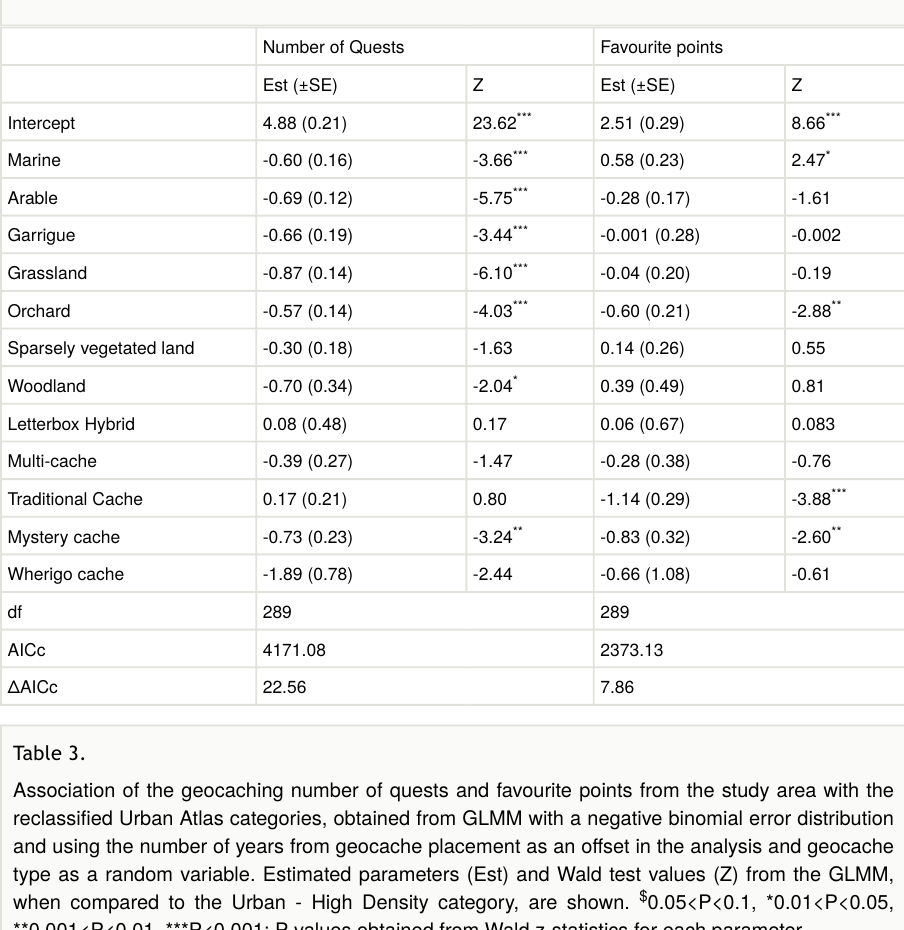
Parameter estimates using GLM with a negative binomial distribution for the number of quests and favourite points when compared to the Urban LULC are shown. The most parsimonious model (lowest Akaike Information Criterion with a second order correction, AICc) for each response variable was selected as the best model. *0.01<P<0.05, **0.001<P<0.01, ***P<0.001;(cid:10) P values obtained from Wald test statistic (Z) for each parameter. Number of Quests Favourite points